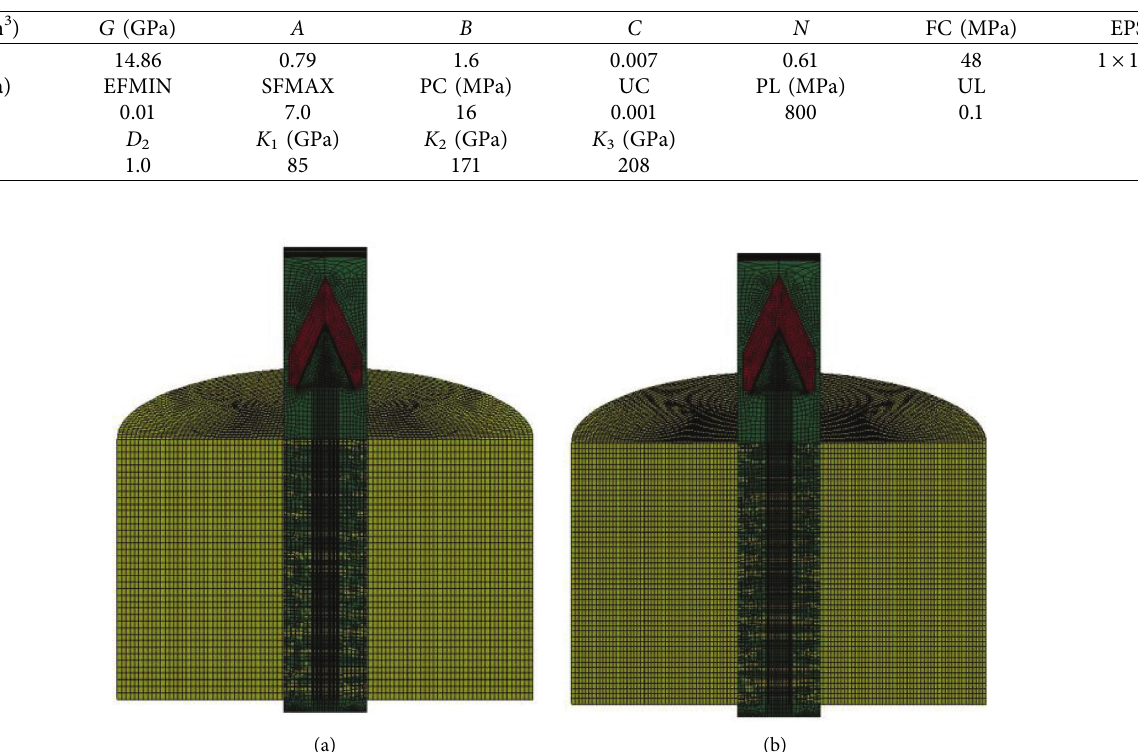
Figure 3: The 1/2 model of numerical simulation. (a) Case 1: H � 30mm, l � 40mm. (b) Case 2: H � 40mm, l � 30 mm.